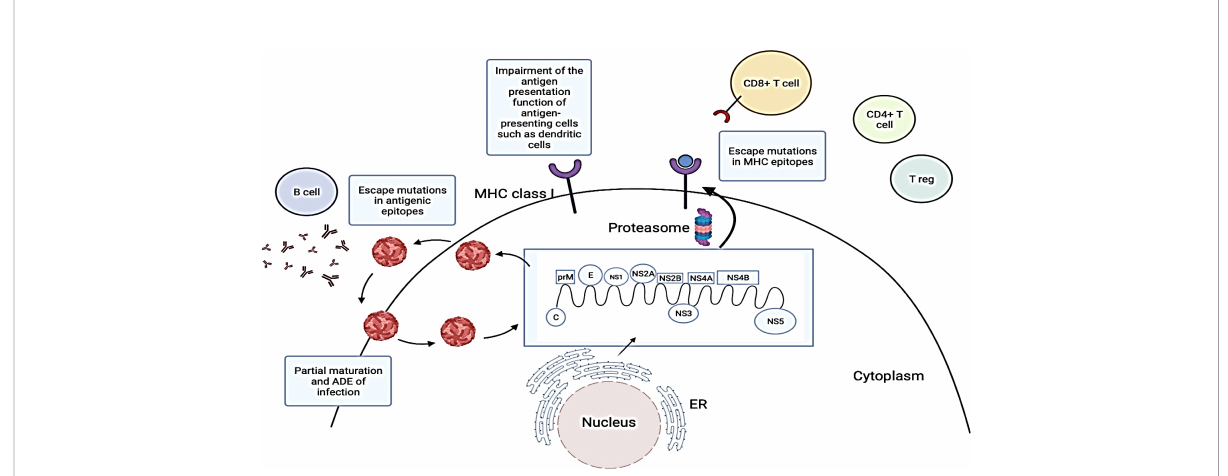
FIGURE 3 Strategies employed by dengue virus (DENV) to evade adaptive immune responses. DENV viral proteins are produced by translating the DENV RNA genome. DENV structural proteins and progeny RNA genomes are then assembled into new viral particles which are released via the secretory pathway. These viral proteins are usually degraded by proteasomes and peptides associated with major histocompatibility complex (MHC) class I molecules are presented on the surface of DENV-infected cells to CD8+ T cells. However, DENV may undergo antigenic mutations to evade recognition by neutralizing antibodies and T cells (Chareonsirisuthigul et al., 2007; Martinez et al., 2020). They can also evade adaptive immune responses by promoting viral entry into cells through pre-existing antibodies and inhibiting antigen presentations by antigen-presenting cells. The fi gure has been created with Biorender.com (ON, Canada). ADE, Antibody dependent enhancement; C, Capsid protein; E, Envelope protein; ER, Endoplasmic reticulum; prM, Pre-membrane protein; NS1, Non-structural 1 protein; NS2A, Non-structural 2A protein; NS2B, Non-structural 2B protein; NS3, Non-structural 3 protein; NS4A, Non-structural 4A protein; NS4B, Non-structural 4B protein; NS5, Non-structural 5 protein.miRNAs as potential therapeutics for dengue